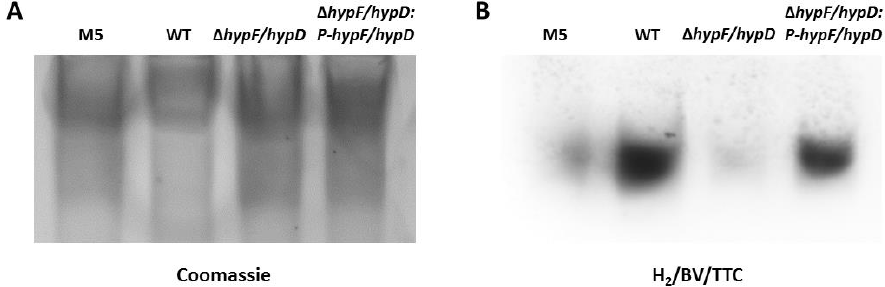
Figure 2. Zymogram of hydrogenase activity showing HypF/HypD is required for H 2 dependent reduction of 2.0 mM 2,3,5,-triphenyltetrazolium chloride (TTC) by the [NiFe]-hydrogenase. Sixty micrograms of total protein derived from M5, WT, ∆ hypF/hypD, and ∆ hypF/hypD: p-hypF/hypD grown anaerobically in Clostridial growth medium (CGM) containing 6.0% glucose was subjected to non-denaturing PAGE. ( A ) Image of gel containing cell lysates stained with Coomassie Simply Blue; ( B ) Image of the gel containing cell lysates stained under a hydrogen atmosphere with benzyl viologen (BV) and TTC as electron acceptors.